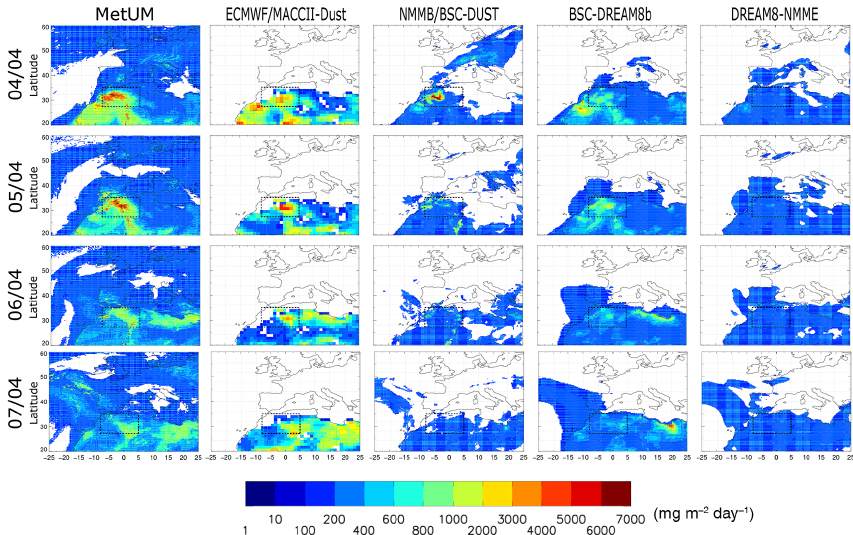
Figure 12. Total accumulated forecasted daily deposition with 24h lead time for the models MetUM, ECMWF/MACCII-Dust, NMMB/BSC- DUST, BSC-DREAM8b and DREAM8-NMME (from left to